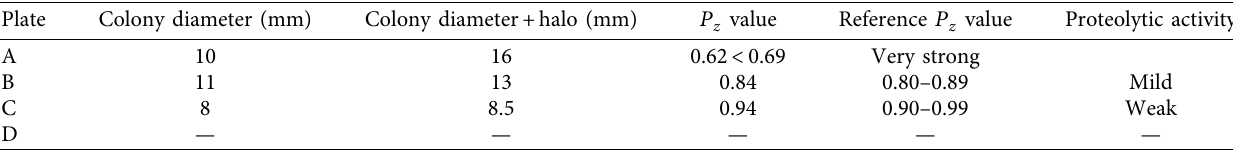
P z value is the ratio of the diameter of the colony to the total diameter of the colony plus the zone of